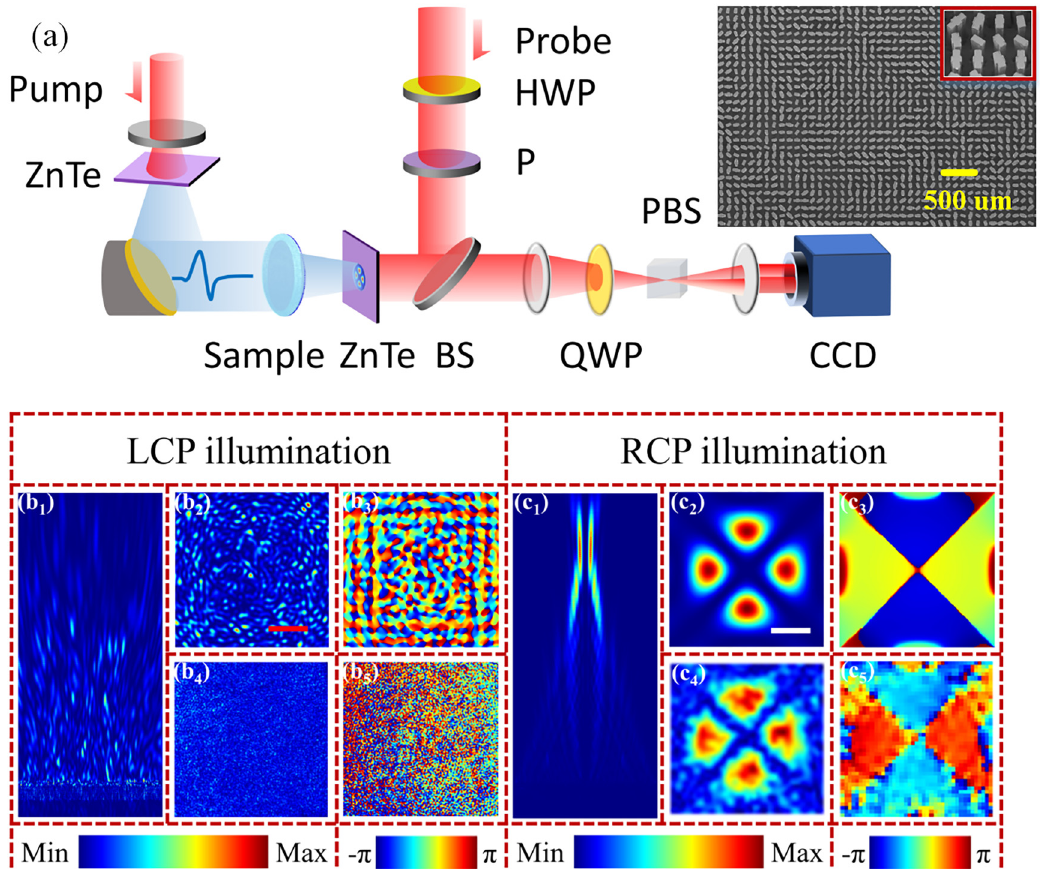
Figure5: (a)Schematics oftheTHzdigitalholographicimagingsystem.(Half-waveplate[HWP];polarizer[ P ];quarter-waveplate[QWP],beam splitter[BS]; polarization beamsplitter[PBS];charge coupleddevice [CCD]).Inset showsthe SEMimages of the metasurface-5. (b) and(c) The simulated and experimental results of the metasurface-5 under the LCP/RCP illumination, respectively. The red scale bar is 2 mm and the white one is 300 μ